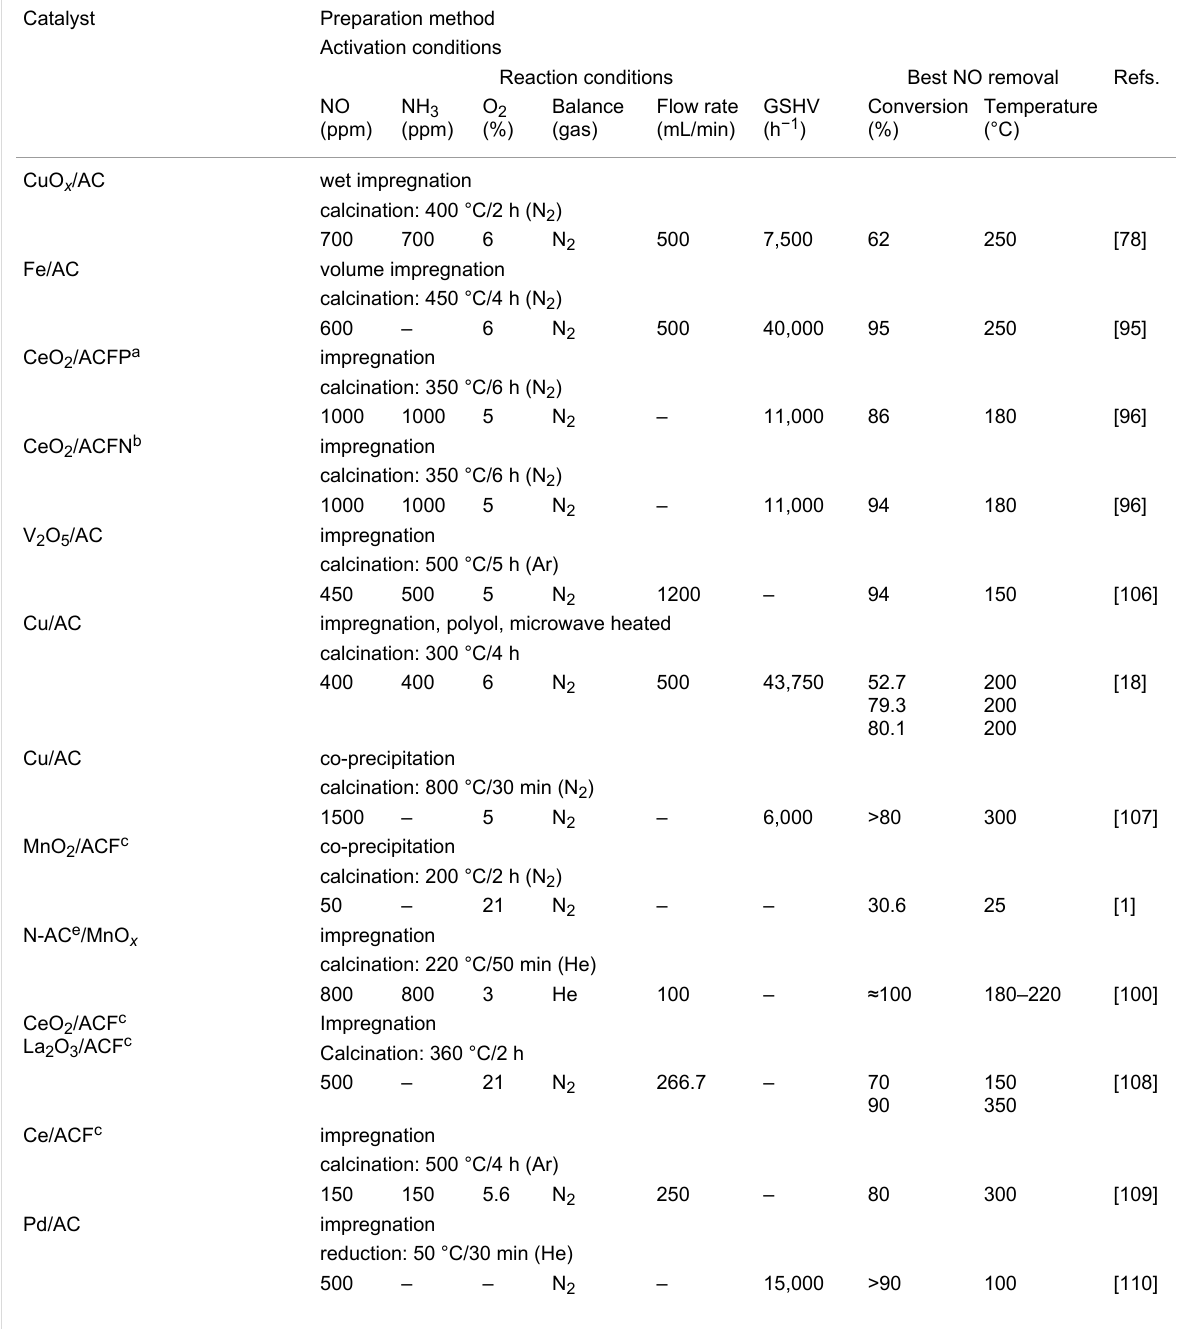
Table 3: Summary on the reaction conditions and NO activity for activated carbon and activated carbon fiber supported based catalysts.